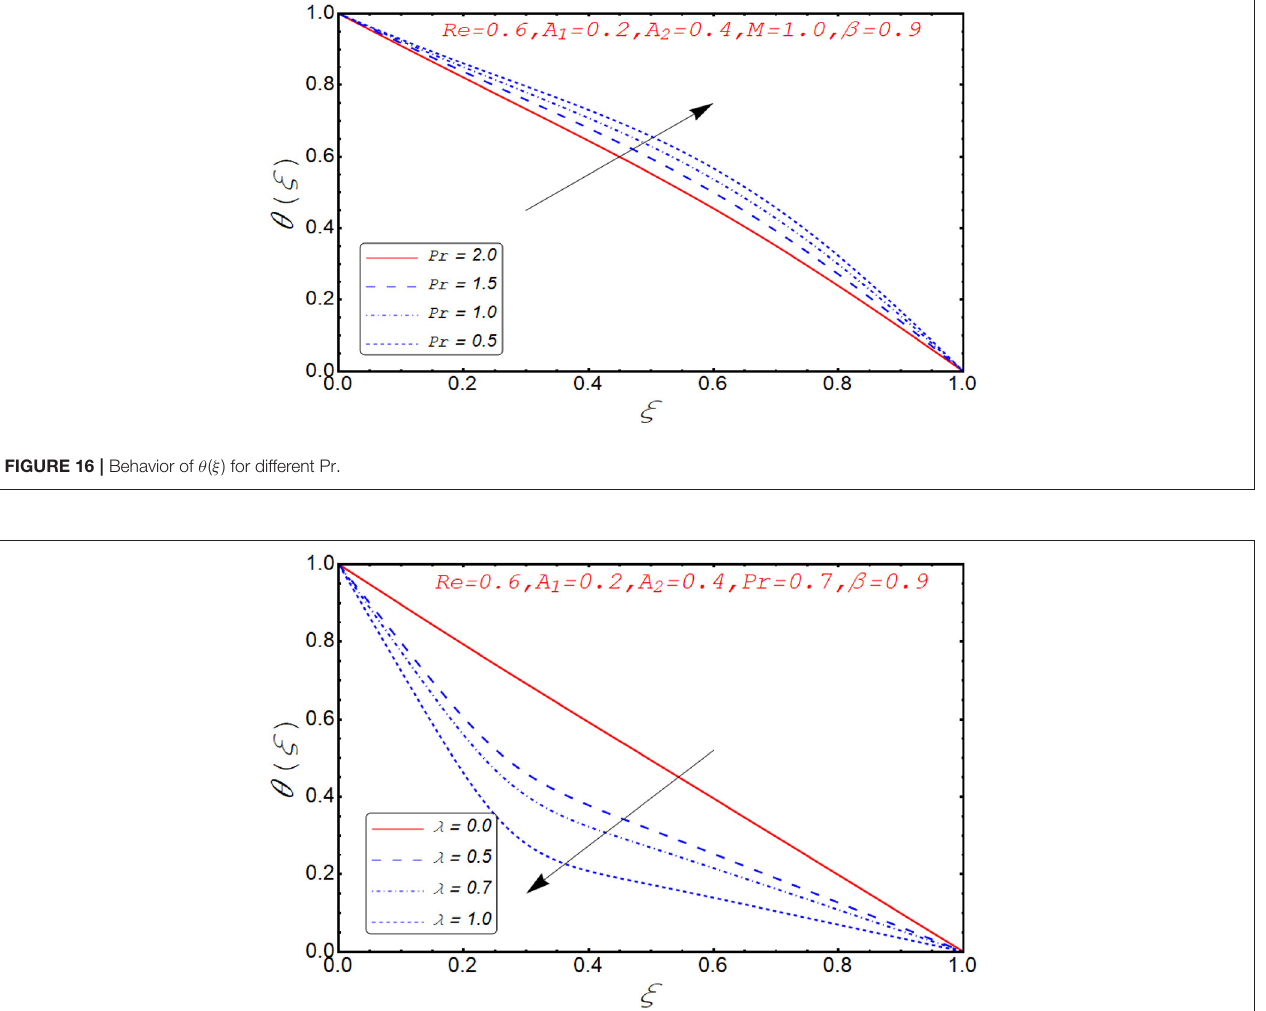
FIGURE 17 | Behavior of θ ( ξ ) for different λ